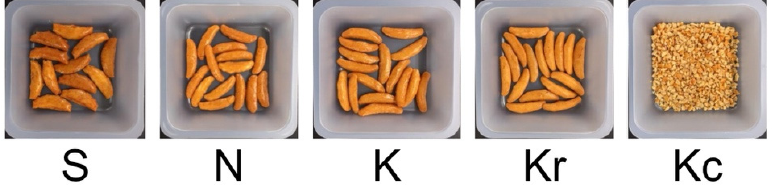
Figure 1. Examples of each “Kakinotane” sample. Numbers S, K, and N are available commercially and produced by different manufactures. Sample Kr was a moisturized and re-dried version of K, and Kc was a crushed version of K.